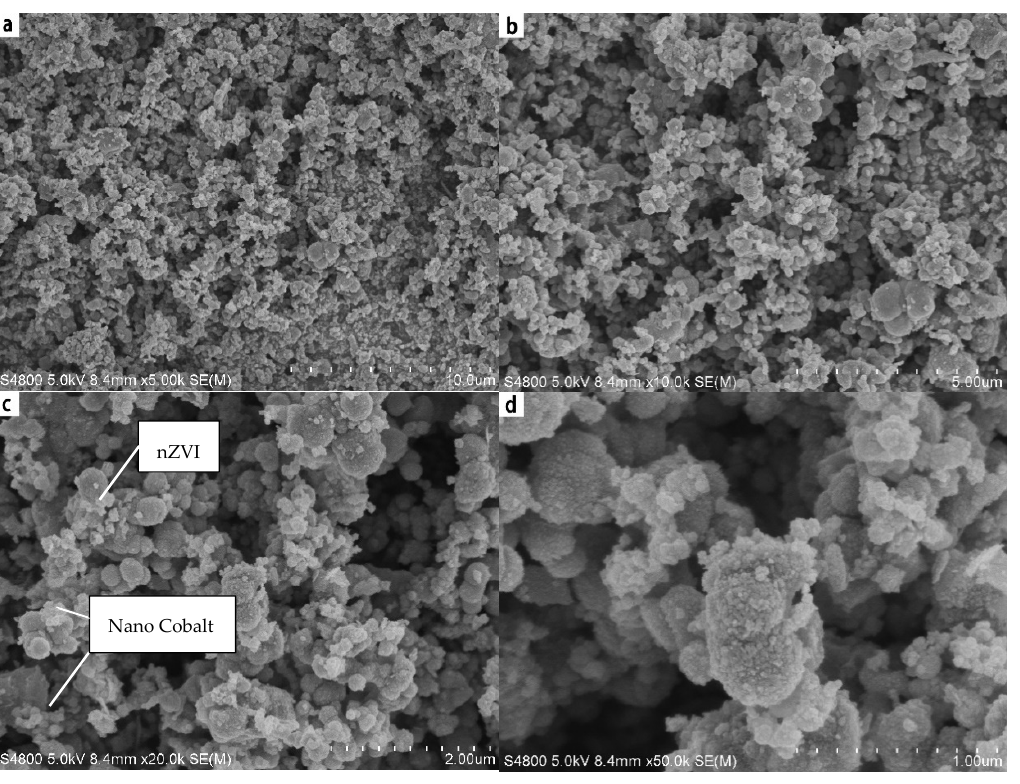
Figure 3. SEM of Co-nZVI/GAC before reaction.The sample is magnified 5000 times ( a ), The sample is magnified 10,000 times ( b ), The sample is magnified 20,000 times ( c ), The sample is magnified 50,000 times ( d ).